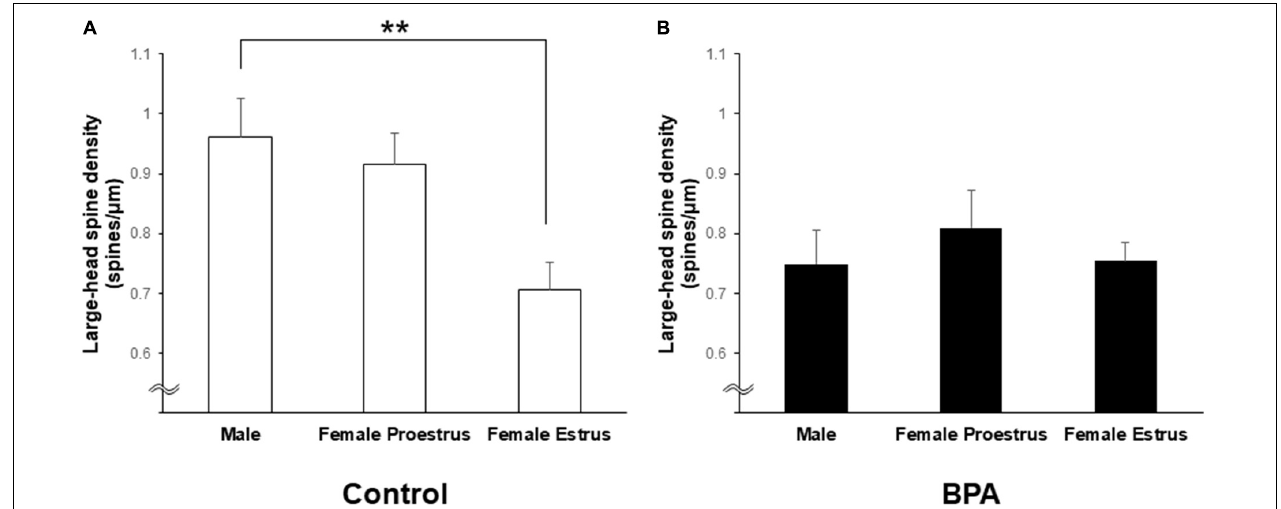
FIGURE 6 | Changes in the density of large-head spines in the hippocampus of grownup male and female rats by perinatal BPA exposure. (A) Comparison of the density of the large-head spines between male, female at proestrus, and female at estrus without perinatal BPA exposure (Control). (B) Effect of BPA exposure on the large-head spine density of male, female at proestrus, and female at estrus with perinatal BPA exposure (BPA). Results are represented as mean ± SEM. Statistical analysis was performed Tukey–Kramer multiple comparison test when one-way ANOVA showed significant difference. Statistical significance yielded, ** p <